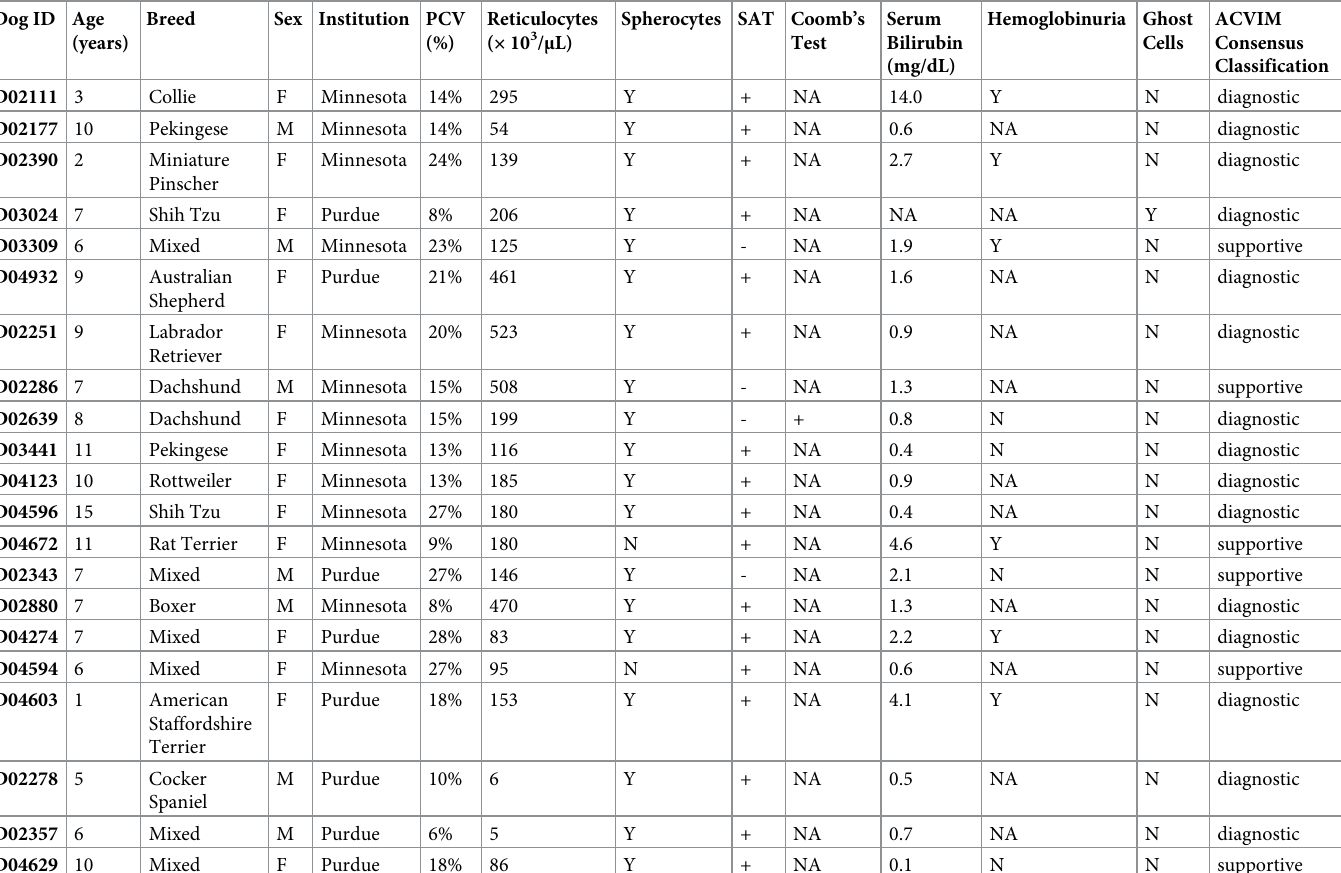
Table 1. Selected demographic and laboratory values for enrolled cases. Dog ID Age (years)